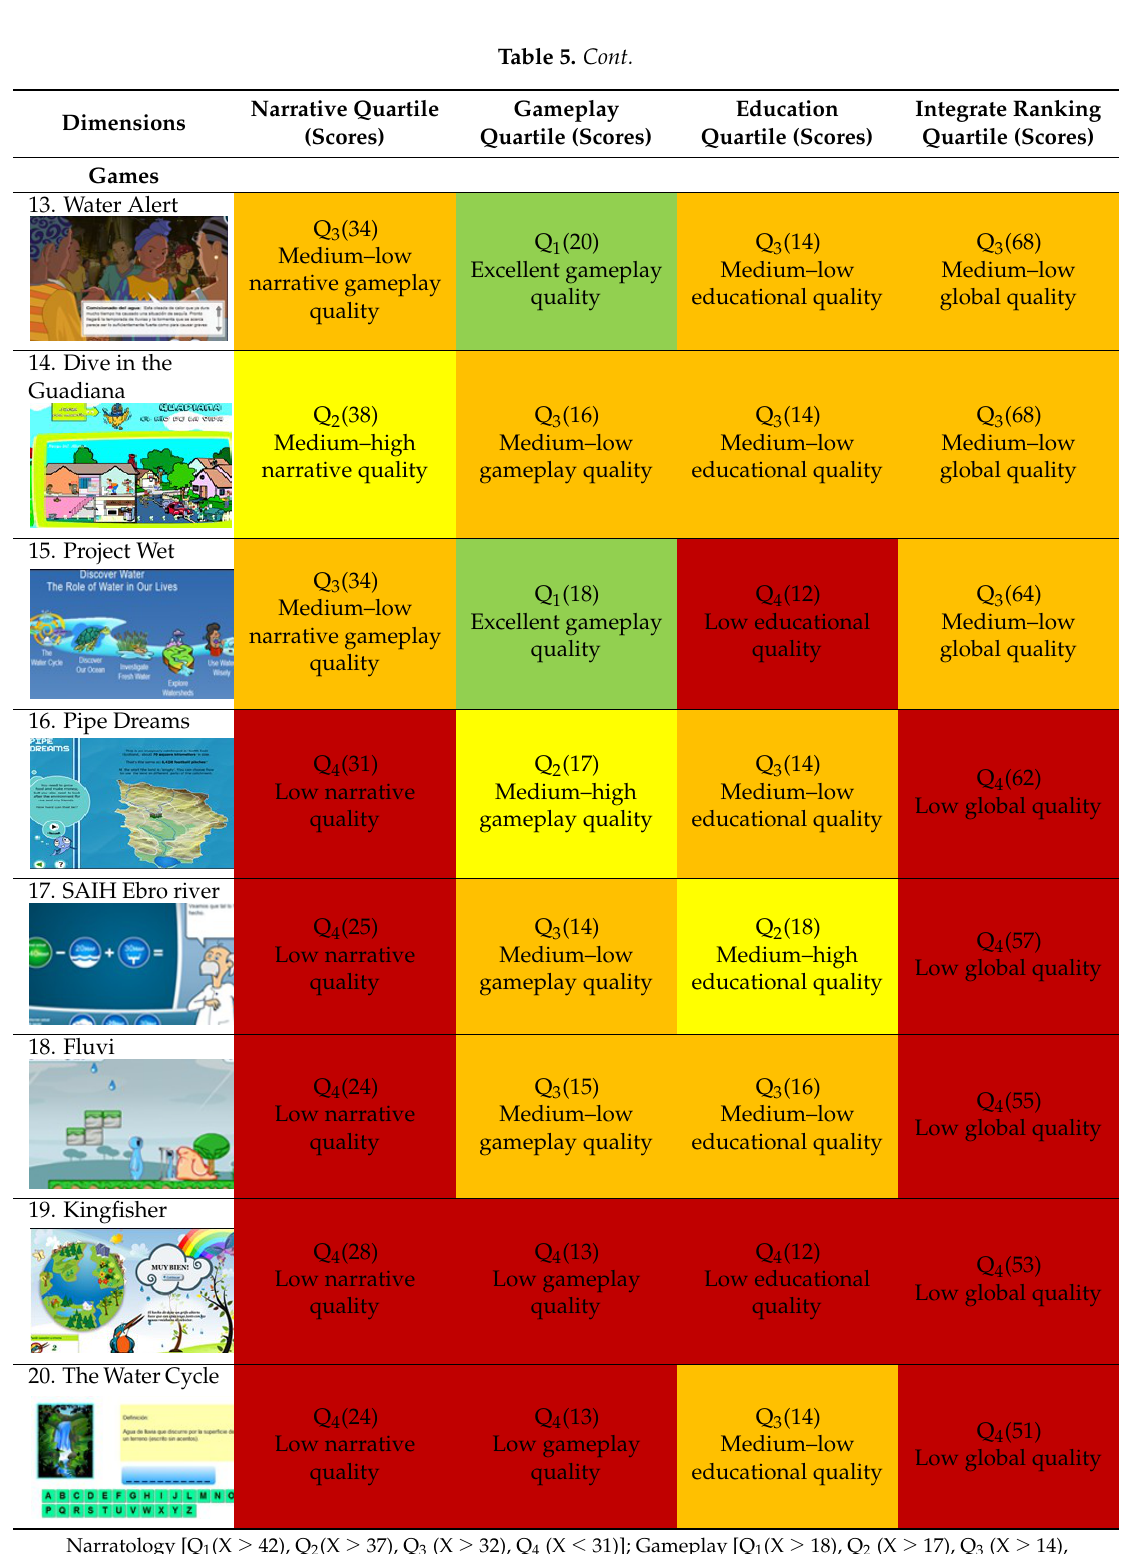
Table 6. Pearson correlations by dimensions. NarrativeGameplayEducation Narrative Pearson correlation